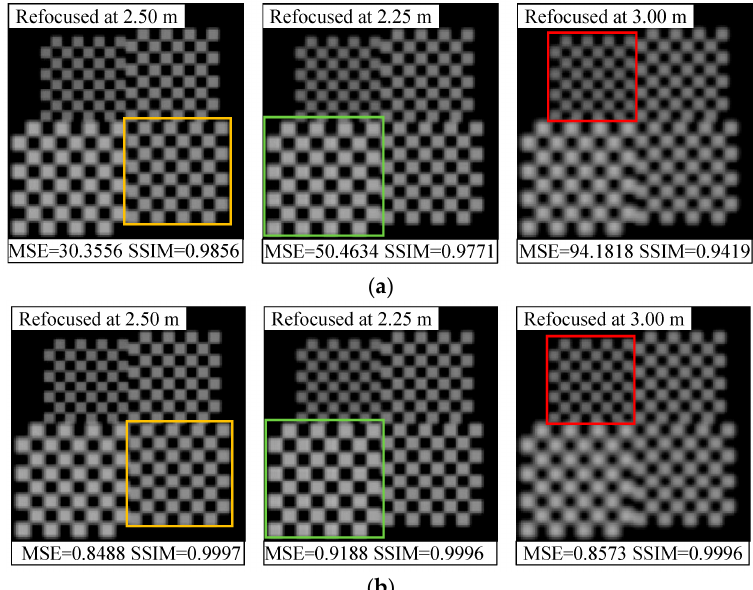
Figure 10. Comparison of refocused images at varying depths for coupled distance error correction: ( a ) With an error of Δ z = 15 μ m; ( b ) After distortion correction. The MSE and SSIM results for each ( a ) With an error of ∆ z = 15 µ m; ( b ) After distortion correction. The MSE and SSIM results for each image are displayed at the bottom. image are displayed at the bottom.